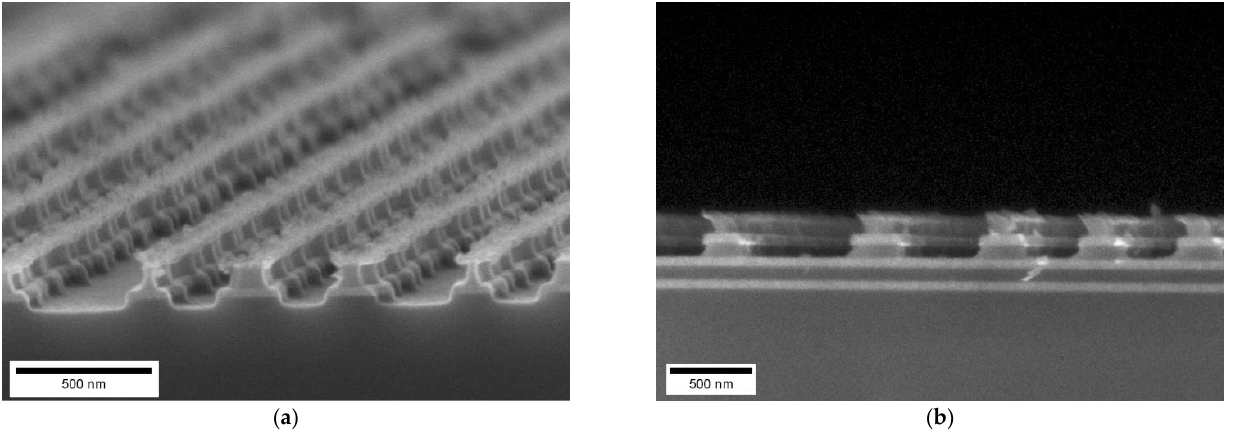
Figure 3. A PTM-Si-stack is etched by a F-based RIE process. ( a ) single layer PTM/Si-stack and ( b ) quadruple layer PTM/Si-stack. The cross-sections were fabricated by cleaving the wafer. Images were recorded by SEM on a vertically mounted master chip.